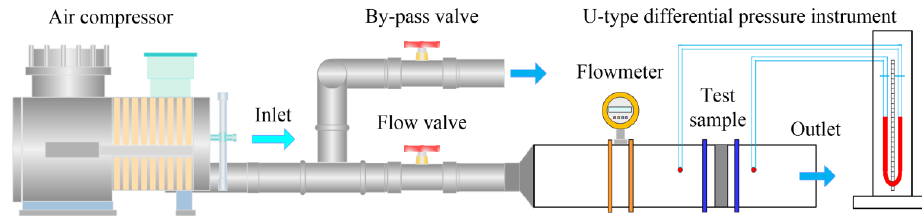
Figure 3. Schematic diagram of air permeability test of C WCMs